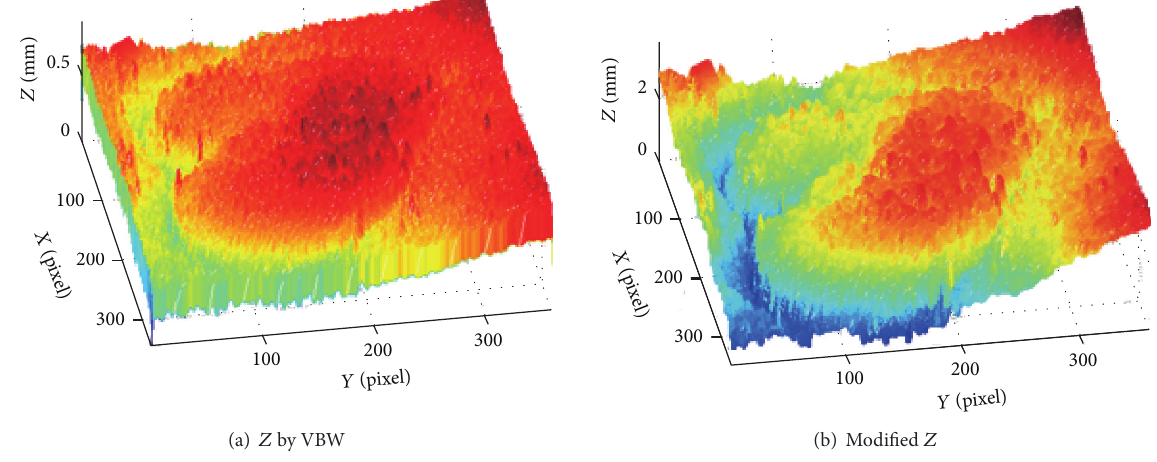
Figure 13: Result for endoscope